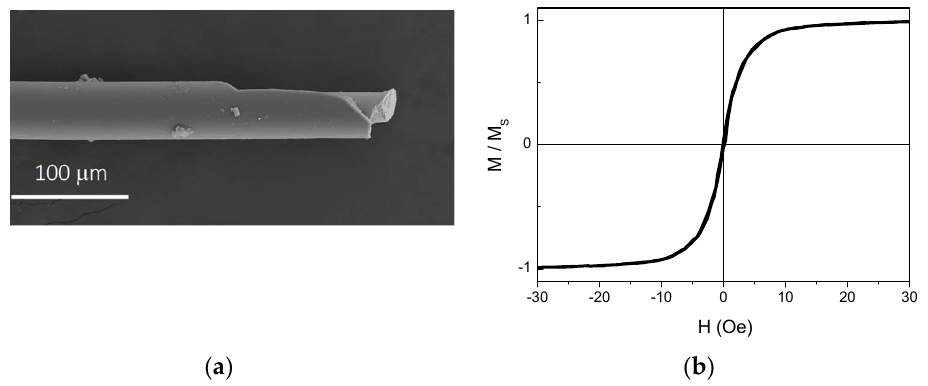
Figure 1. ( a ) SEM general view of a representative microwire consisting of a metallic inner core and a Pyrex cover. ( b ) Room temperature hysteresis loops of a L = 0.5 cm amorphous ferromagnetic microwires with an axial applied magnetic field.